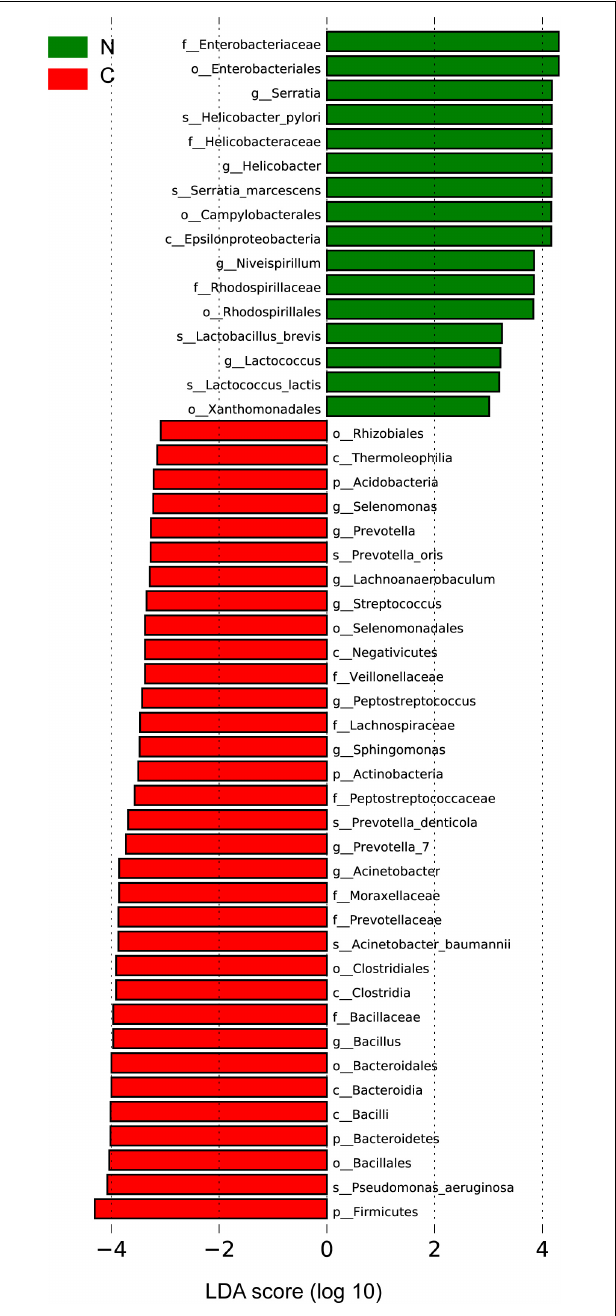
FIGURE 3 | Differential bacteria between the two groups by LEfSe analysis (LDA scores > 3.0). Green indicates taxa enriched in non-cancerous tissues and red indicates taxa enriched in cancerous tissues. C, cancer group; N, non-cancer group.